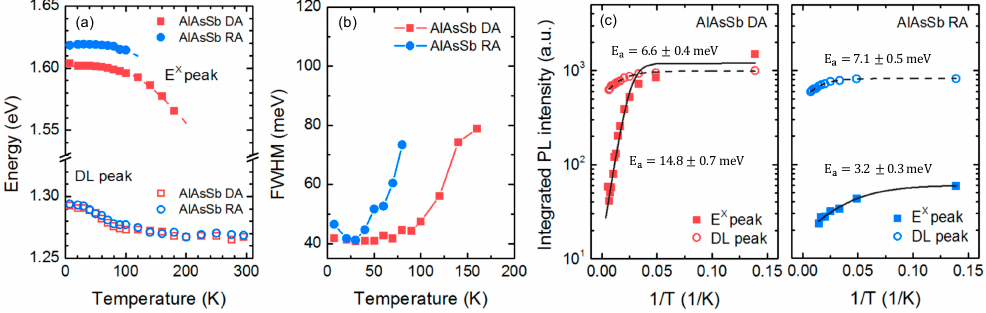
Figure 4. Temperature-dependent measurement of ( a ) peak energies; ( b ) peak FWHM; and ( c ) integrated PL intensities of the E X and DL peaks for the AlAsSb DA and RA samples. Table 1. Parameters extracted by fitting experimental data of the AlAsSb DA and RA samples.